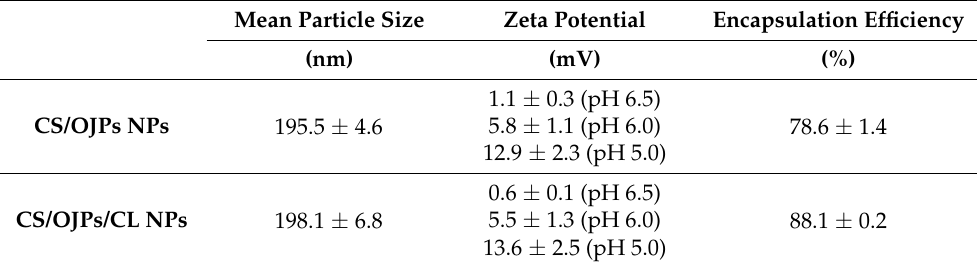
Table 1. Mean particle size (hydrodynamic diameter), zeta potentials, and OJPs encapsulation efficiency of CS/OJPs NPs and CS/OJPs/CL